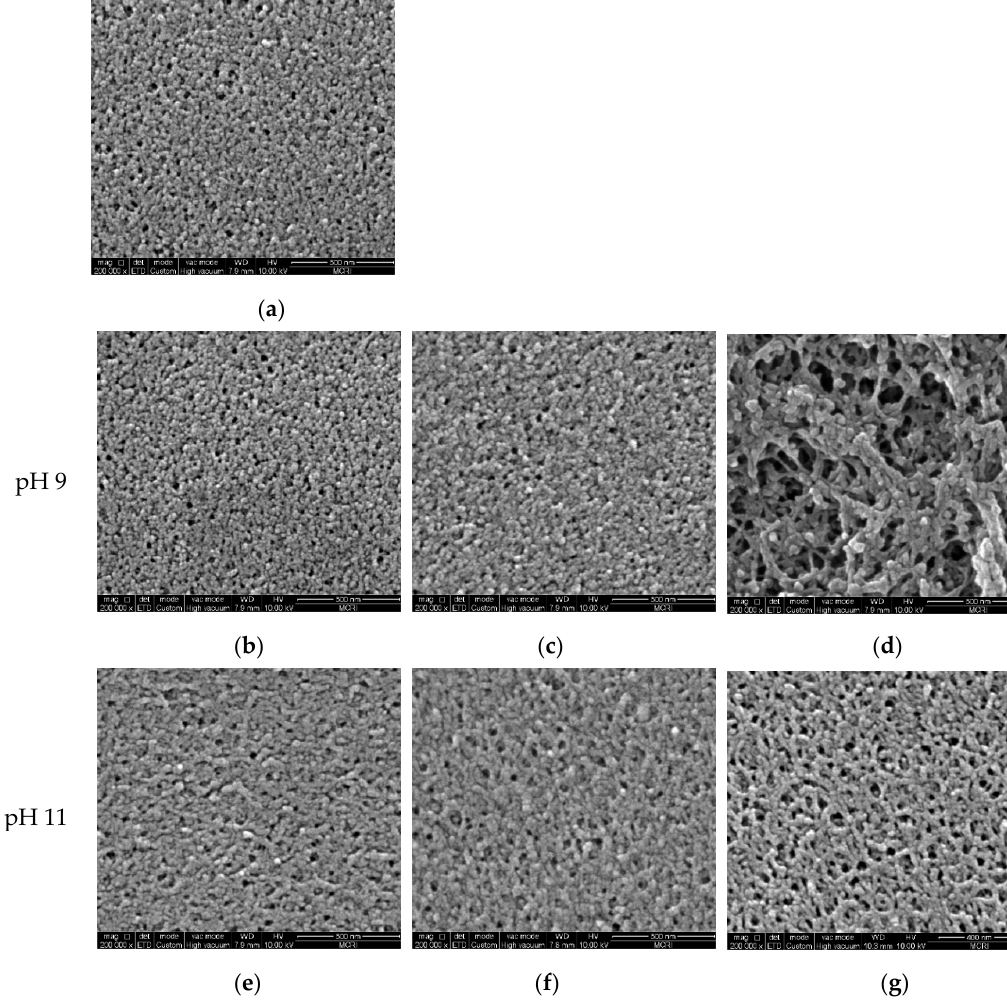
Figure 5. SEM images of pristine and aged PES membrane at the magnification of 200 000: ( a ) pristine; ( b ) control (pH 9); ( c ) H 2 O 2 -aged (pH 9); ( d ) NaClO-aged (pH 9); ( e ) control (pH 11); ( f ) H 2 O 2 -aged (pH 11); and ( g ) NaClO-aged (pH 11). Control membrane indicates membrane samples aged in NaOH solution with pH 9 or 11, c(H 2 O 2 ) = c(NaClO) = 5000 mg/L, t = 100 h.